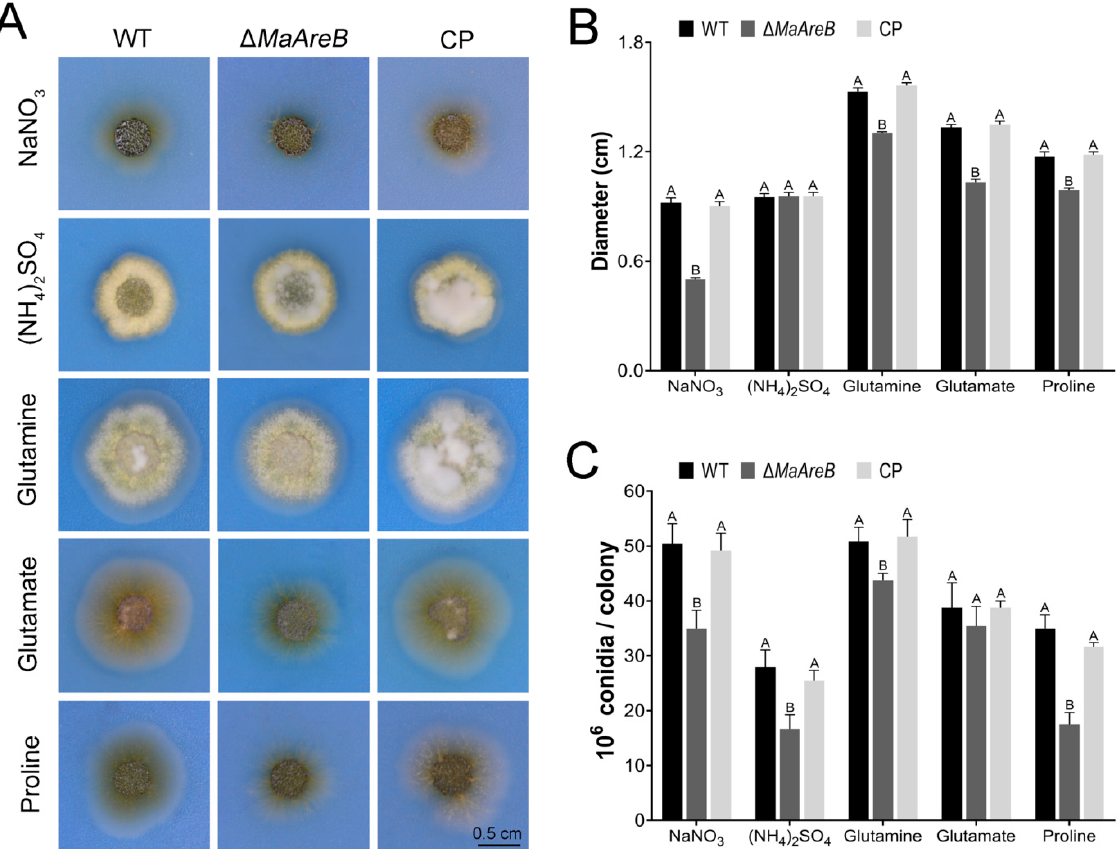
Figure 2. MaAreB was involved in regulating nitrogen utilization. Colony morphology ( A ), colony diameter ( B ) and conidial yield ( C ) of the WT, ∆ MaAreB and CP strains on modified CZA and cultured at 28 °C for 7 days. The concentrations of all nitrogen sources were 10 mM. A & B, p < 0.05 (Tukey’s HSD). The p -values in Figure 2B and C were listed in supplementary Table S3